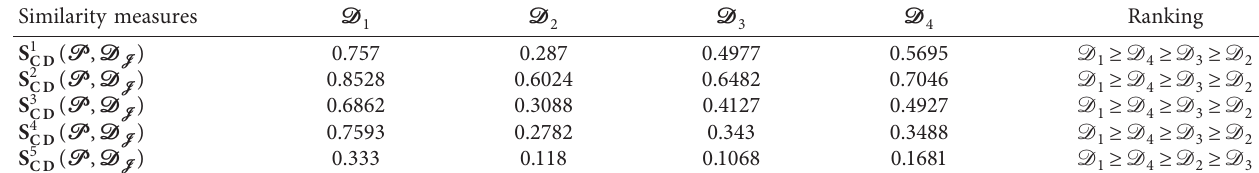
, ϕ ) � ( 0 . 5 , 0 . 5 ) . cc cc